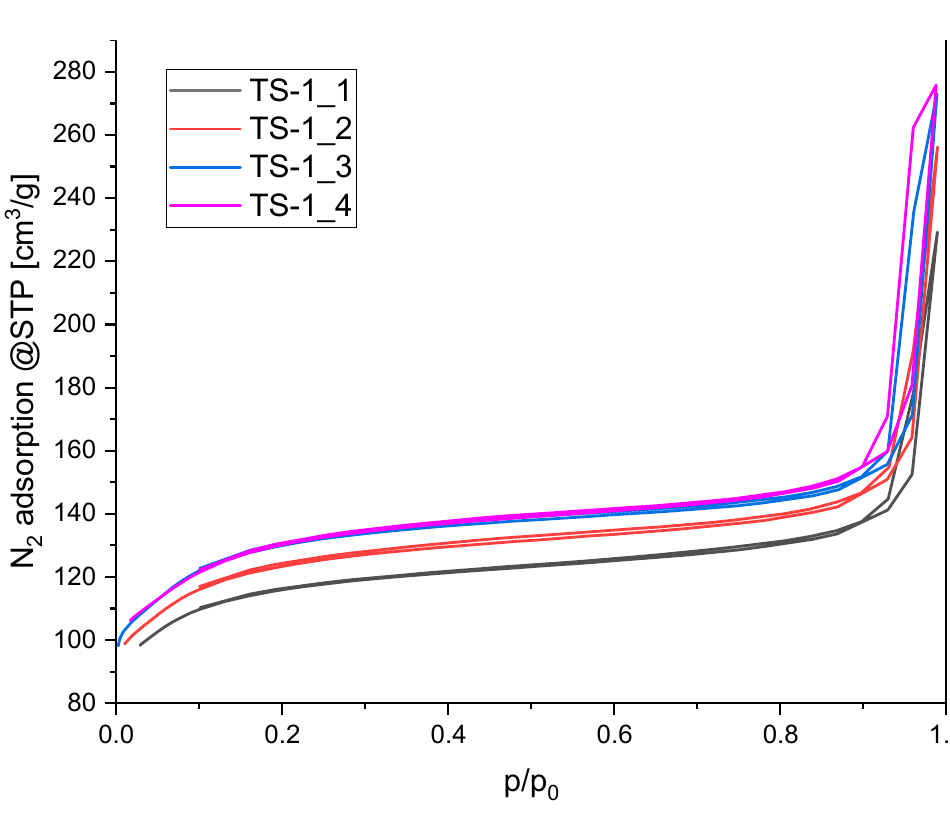
Figure 2. N 2 sorption isotherms at temperature of 77 K.